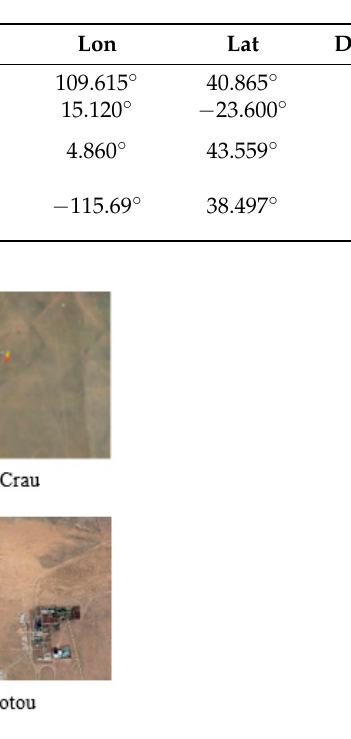
Figure 5. Four RadCalNet sites and corresponding regions of interest.